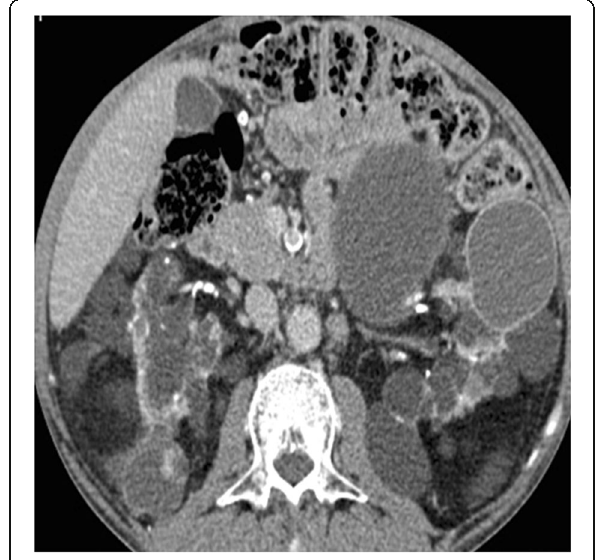
Fig. 12 Acquired cystic renal disease. Axial contrast-enhanced CT image shows atrophic kidneys, which contain multiple cysts of variable